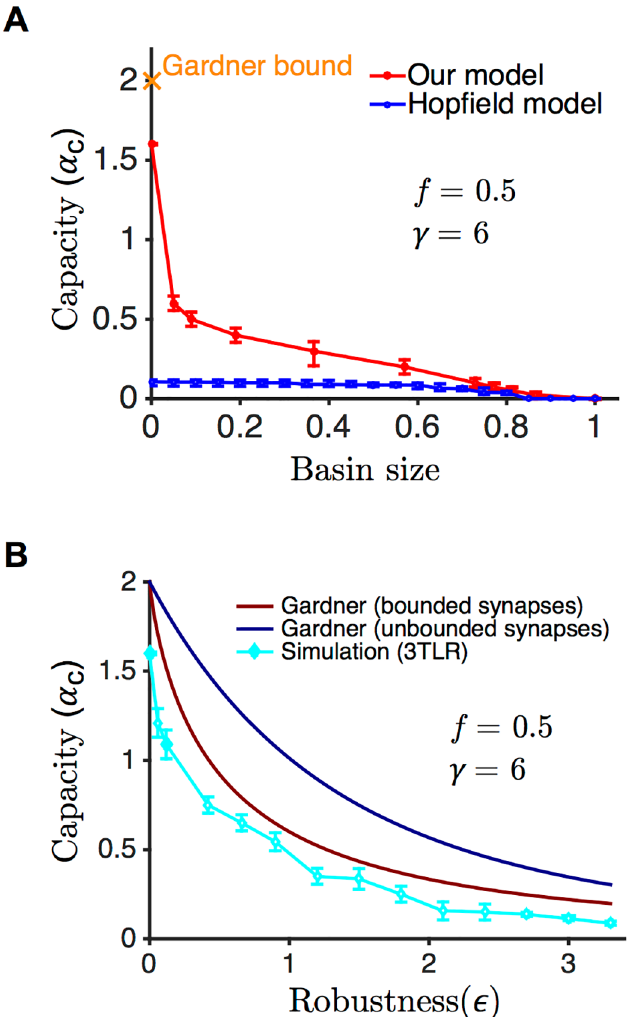
Fig 4. Critical capacity as a function of the basin size and the robustness parameter. A. The red plot shows the critical capacity as a function of the size of the basins of attraction ( N = 1001 neurons in the dense regime f = 0.5) when the strength of the external field is large ( γ = 6) such that the ON and OFF neuronal populations are well separated. The points indicate 0.5 probability of successful storage at a given basin size, optimized over the robustness parameter (cid:2) . The error bars show the [0.95,0.05] probability interval for successful storage. The blue plot shows the performance of the Hopfield model with N = 1001 neurons. The maximal capacity at zero basin size (the Gardner bound) is equal to 2. B. To compare the result of simulation of our model with the analytical results, we plotted the critical capacity as a function of the robustness parameter (cid:2) . The dark red curve is the critical capacity versus (cid:2) for our model obtained form analytical calculations (see Materials and Methods), the cyan line shows the result of simulations of our model, and the dark blue shows the Gardner bound for a network with no constraints on synaptic weights. The difference between the two theoretical curves is due to the constraints on the weights in our network. Fig 4A shows the maximal capacity as a function of the basin size for a simulated network of N = 1001 neurons. We simulated many pairs of ( α , (cid:2) ) with different random seeds, obtaining a probability of success for each pair. The red line shows the points for which the probability of successful storage is 0.5, and the error bars span 0.95 to 0.05 success probability. The capacity was optimized over the robustness parameter (cid:2) . The maximal capacity (the Gardner bound) in the limit of N ! 1 at the zero basin size is α c = 2 for our model (see Materials and Methods